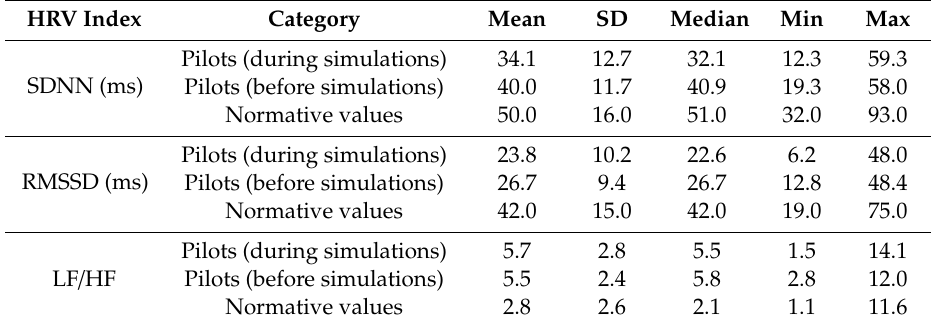
Table 2. Summary statistics of the HRV indices of pilots, compared with the normative values for short-term HRV of healthy adults